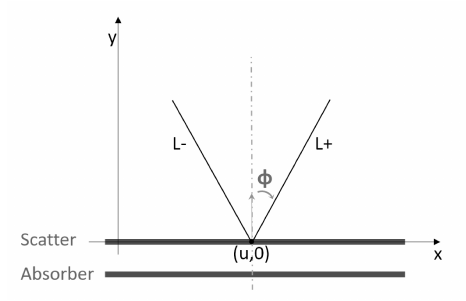
Fig. 3. Geometrical setup of the V-line V ( u, φ )